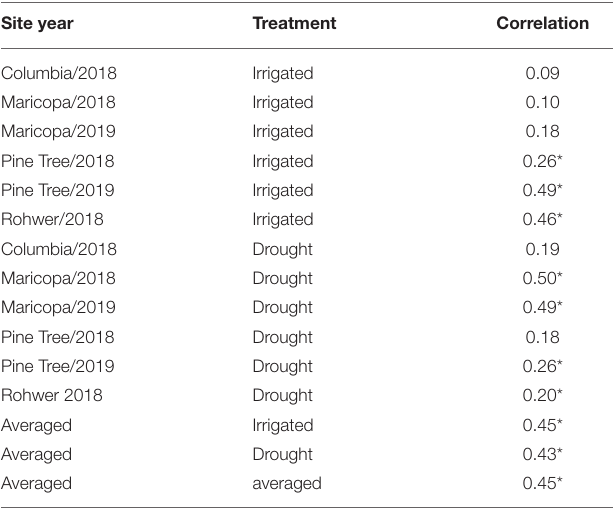
TABLE 5 | Prediction accuracy (correlation) of genomic estimated breeding values (GEBVs) with observed CW scores for the 12 environments for the 100 new accessions used in this